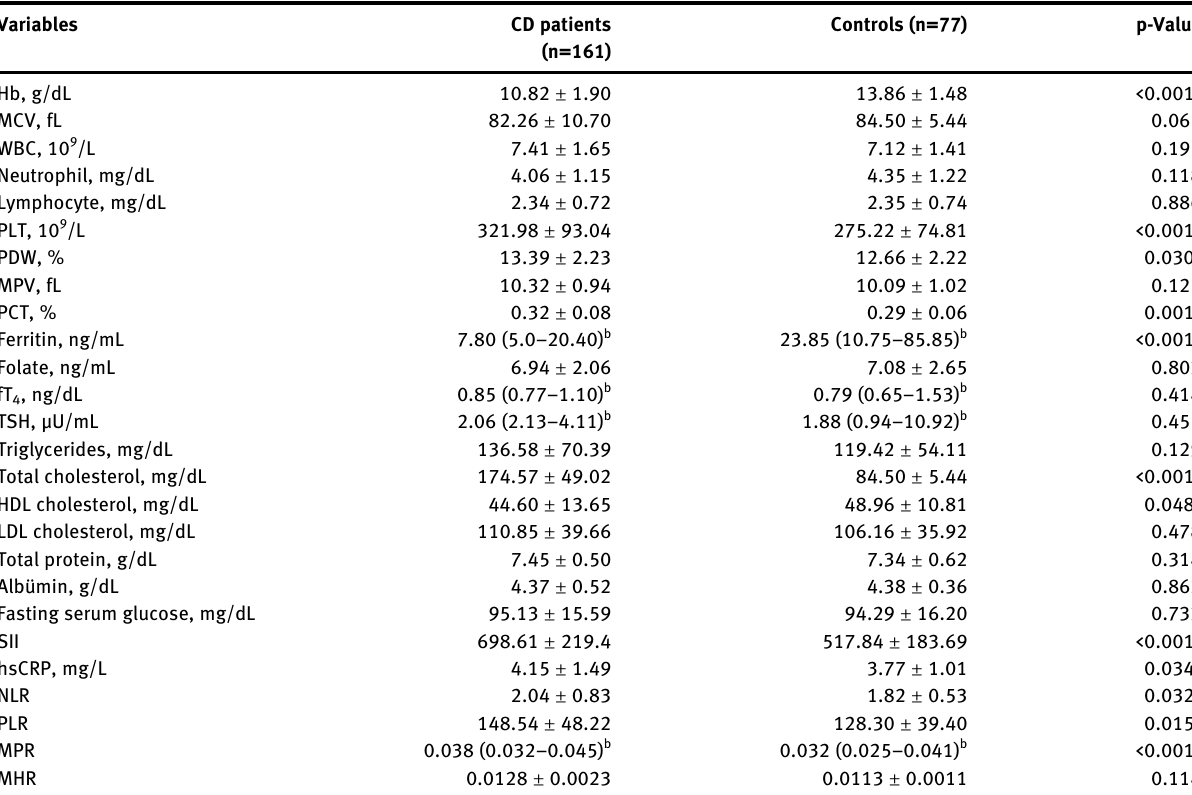
Table  : Biochemical test results of study groups. Variables